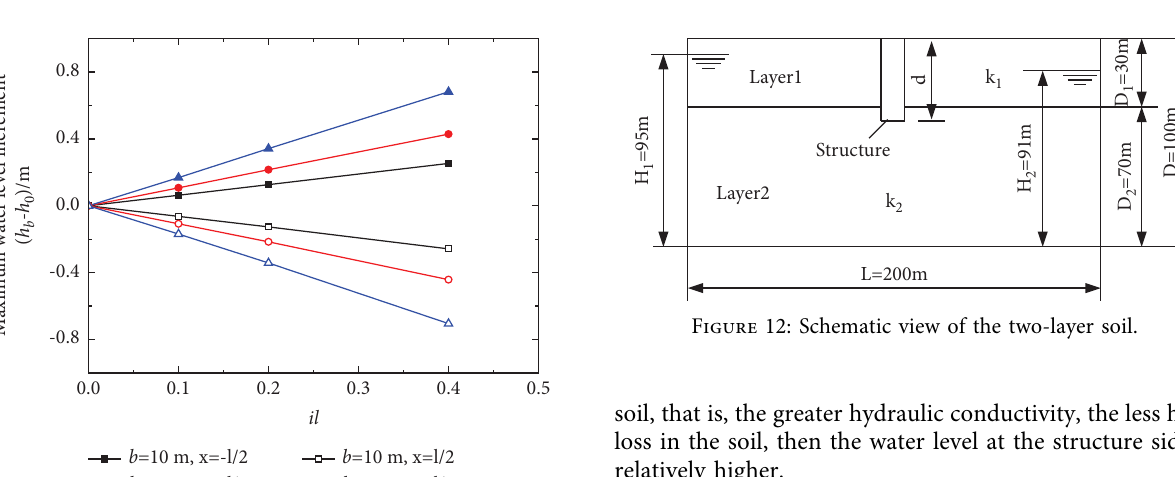
Figure 10: Variation in MWLIR with structure dimensions (a) Infuence of the structure width b . (b) Infuence of the structure length l . (c) Infuence of the structure insertion depth d .